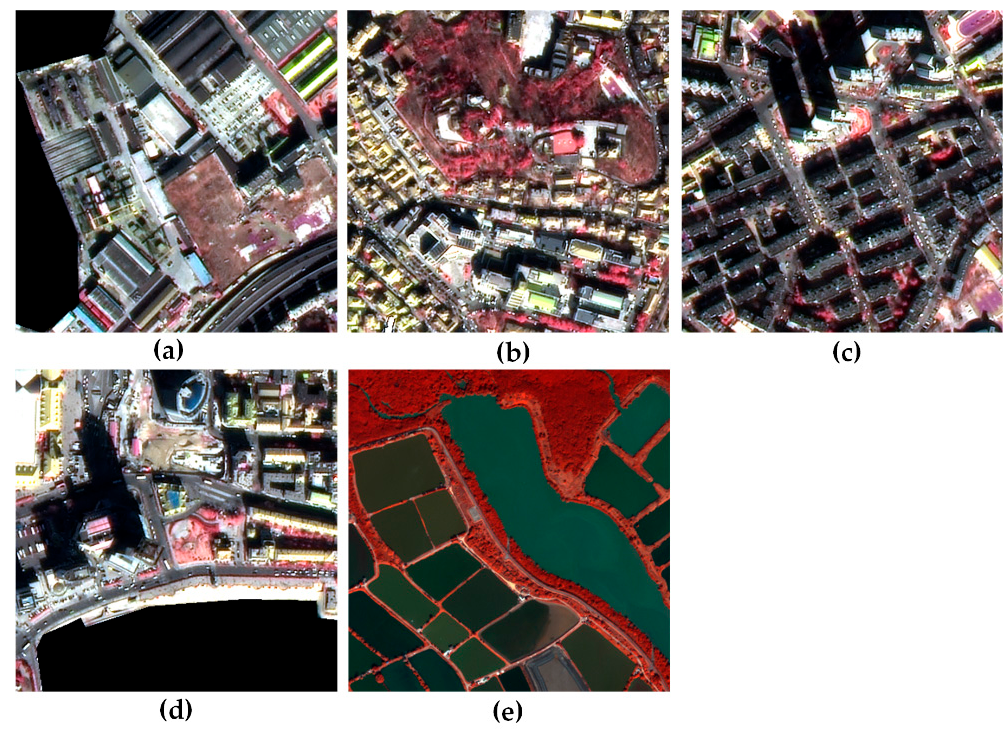
Figure 6. The zoomed in respective areas. ( a ) T1: wharf area; ( b ) T2: hilly city; ( c ) T3: residential area; ( d ) T4: bathing beach; ( e ) T5: aquafarm.